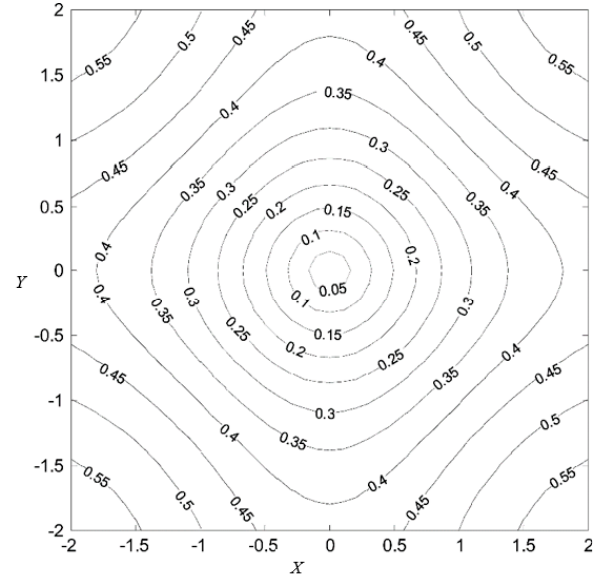
Figure 1. The CIM contour map in 2-D.